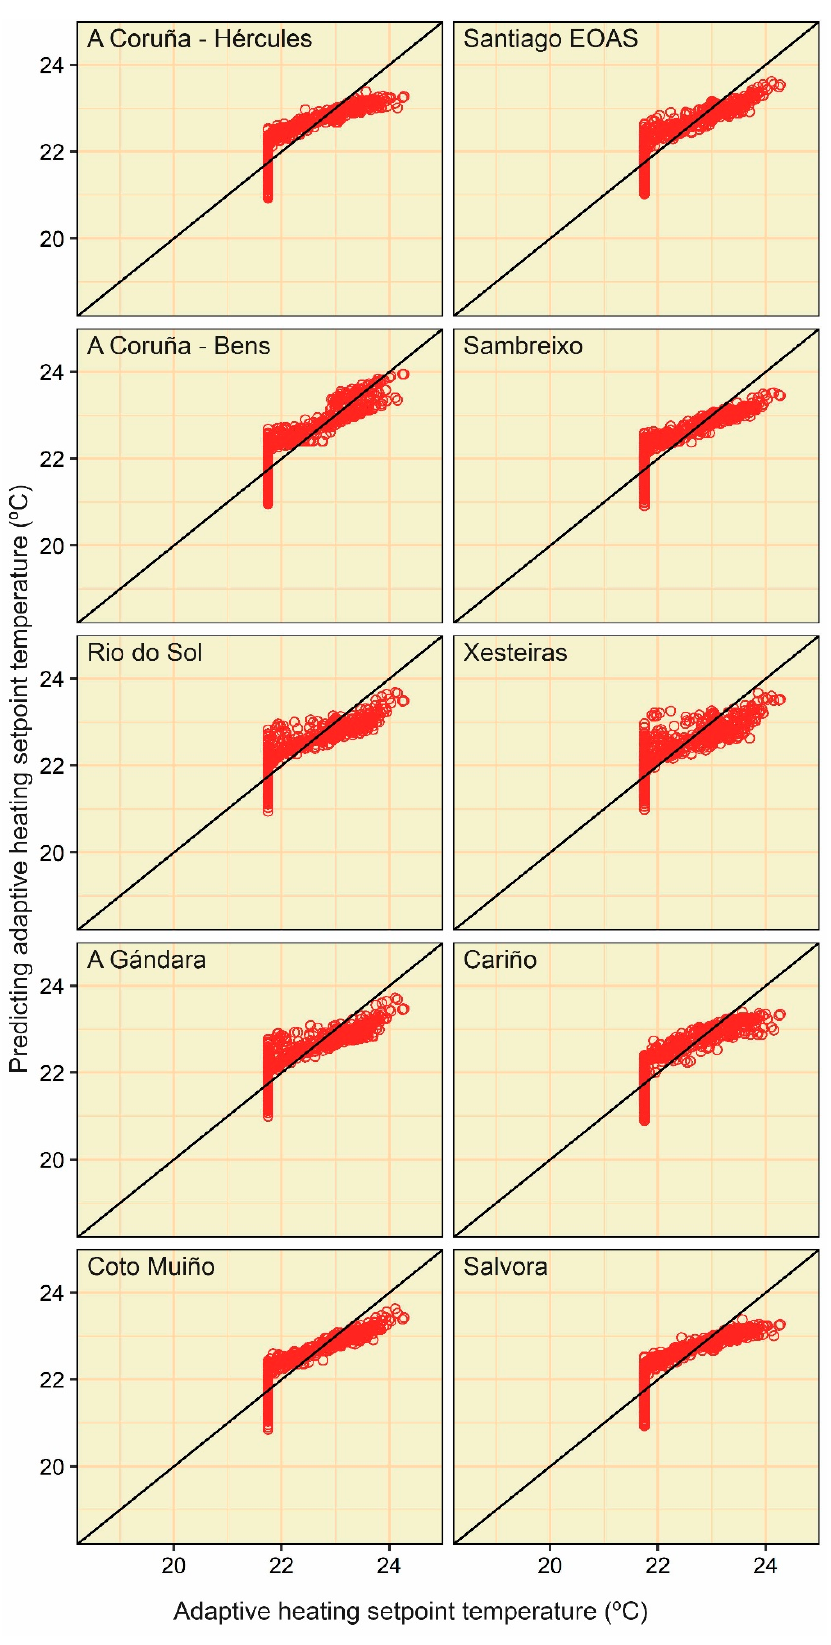
Figure A19. Point clouds between the actual and predicting adaptive heating setpoint temperature values (category I) of the MLR (approach 2).